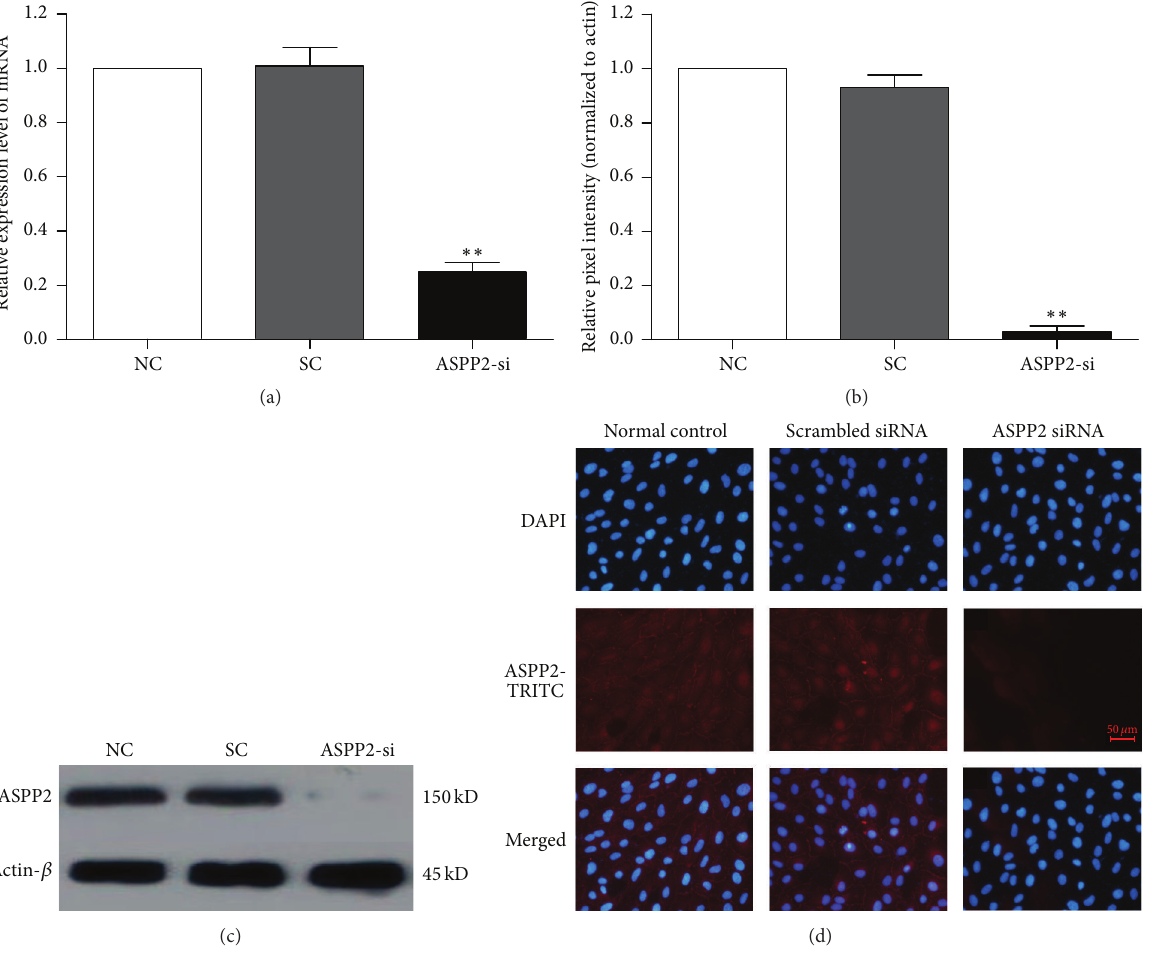
Figure 2: Knockdown of ASPP2 with siRNA efficiently inhibits ASPP2 expression. (a) ASPP2 mRNA expression was significantly downregulated in ARPE-19 cells 48 h after transfection, as measured by real-time RT-PCR. (b) The data of the relative ASPP2 protein in the NC, SC, and ASPP2-siRNA treatment group, normalized to 𝛽 -actin. (c) Representative western blot showing the decreased protein expression of ASPP2 in ARPE-19 cells with ASPP2-siRNA transfection. (d) Cells stained with antibody against ASPP2 (red) and cell nuclei with DAPI were examined by fluorescence microscopy. The fluorescence intensity represents the protein expression of ASPP2 in ARPE-19 cells. Data are shown as the mean ± SD, 𝑛 = 3 . ∗∗ 𝑃 < 0.01 versus NC or SC group. NC was set to 100%. NC, normal control cells; SC, scrambled control-siRNA-transfected cells; ASPP2-si, ASPP2-siRNA-transfected cells; DAPI, 4 󸀠 ,6 󸀠 -diamino-2-phenylindole. Scale bars, 50 𝜇